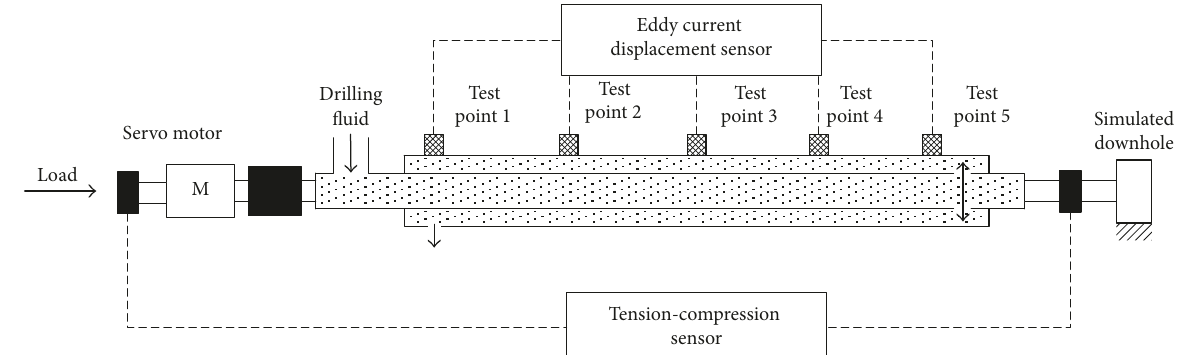
Figure 4: Schematic diagram of the whole structure of the experimental apparatus.